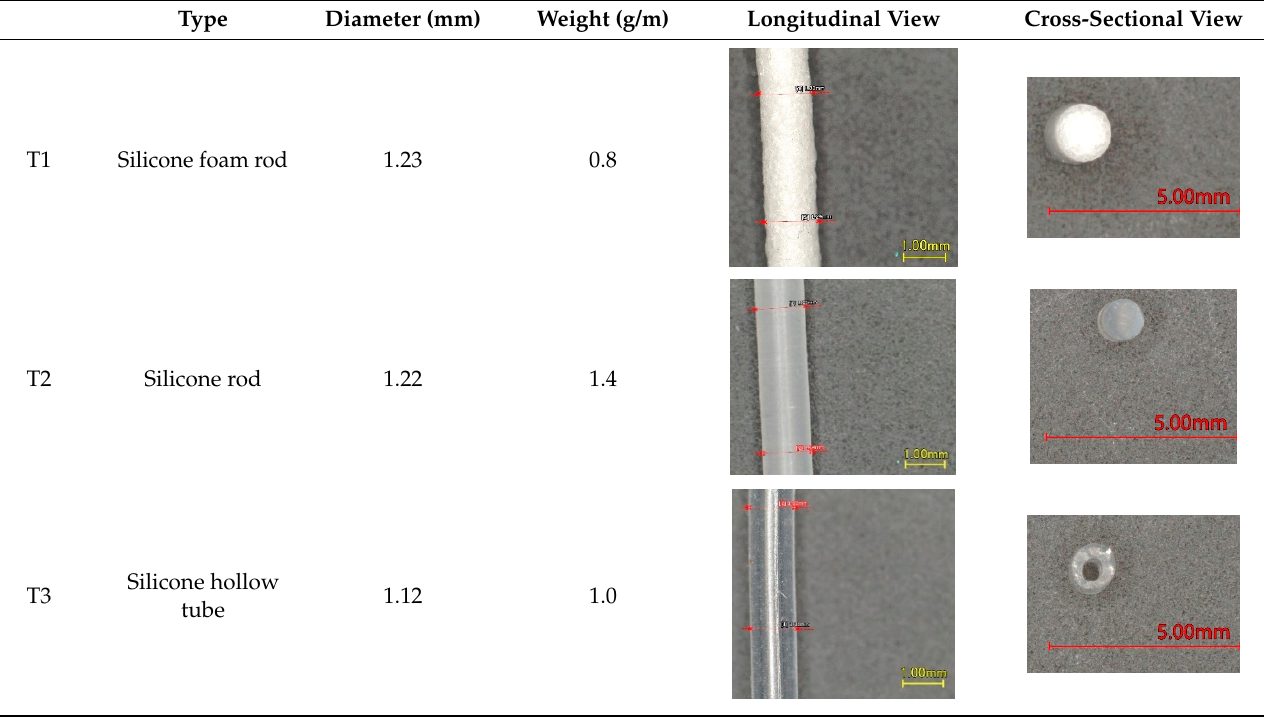
Table 1. Details of the three tubular samples.